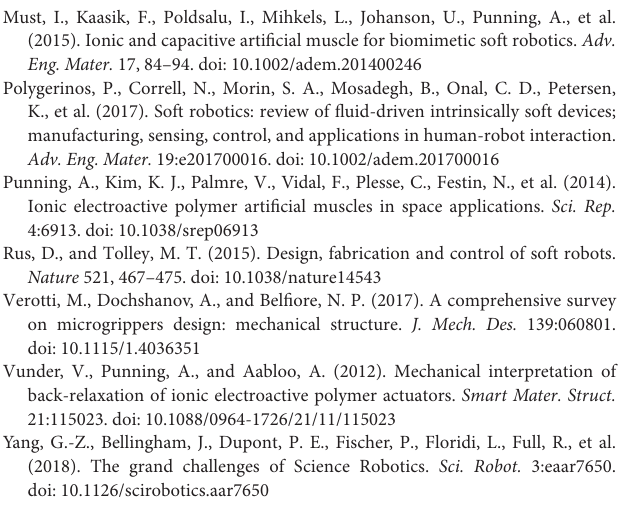
Supplementary Video 1 | Demonstration of an active, ICL-driven pipette for positioning